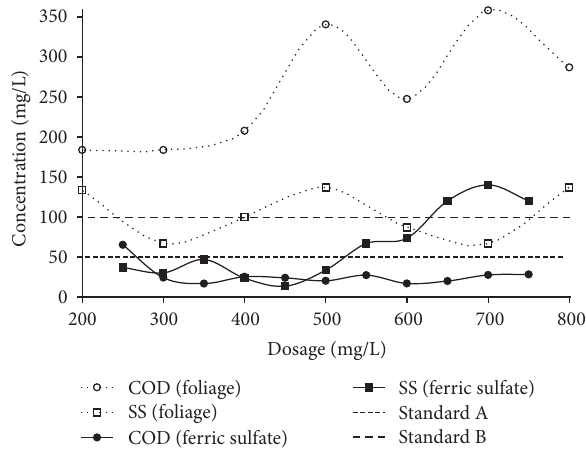
F 5: Comparison analysis of COD and SS concentrations of treated latex effluent(atoptimum pH of10 forfoliageand 7 for ferric sulfate) with standard effluent discharge limits A and B stipulated by the Department of the Environment, Malaysia [14]. Initial COD and SS concentrations were 7857 and 1208,